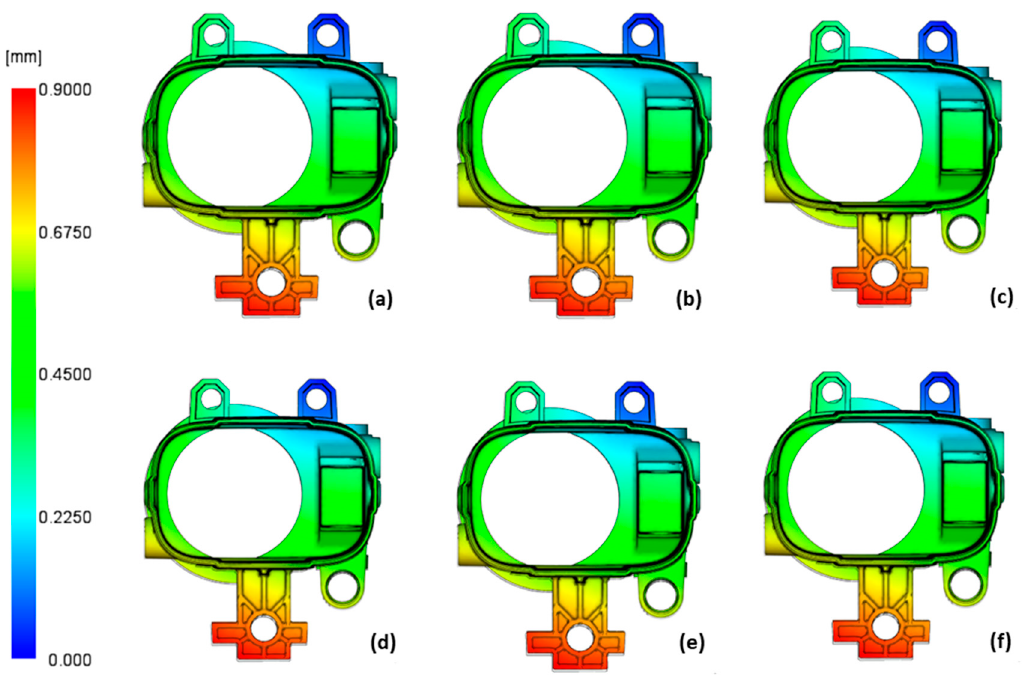
Figure 9. Product temperature results for conventionally cooled case 3 ( a ) and case 21 ( b ) and for the conformally cooled case 19 ( c ), case 20 ( d ), case 23 ( e ), and case 24 ( f ).